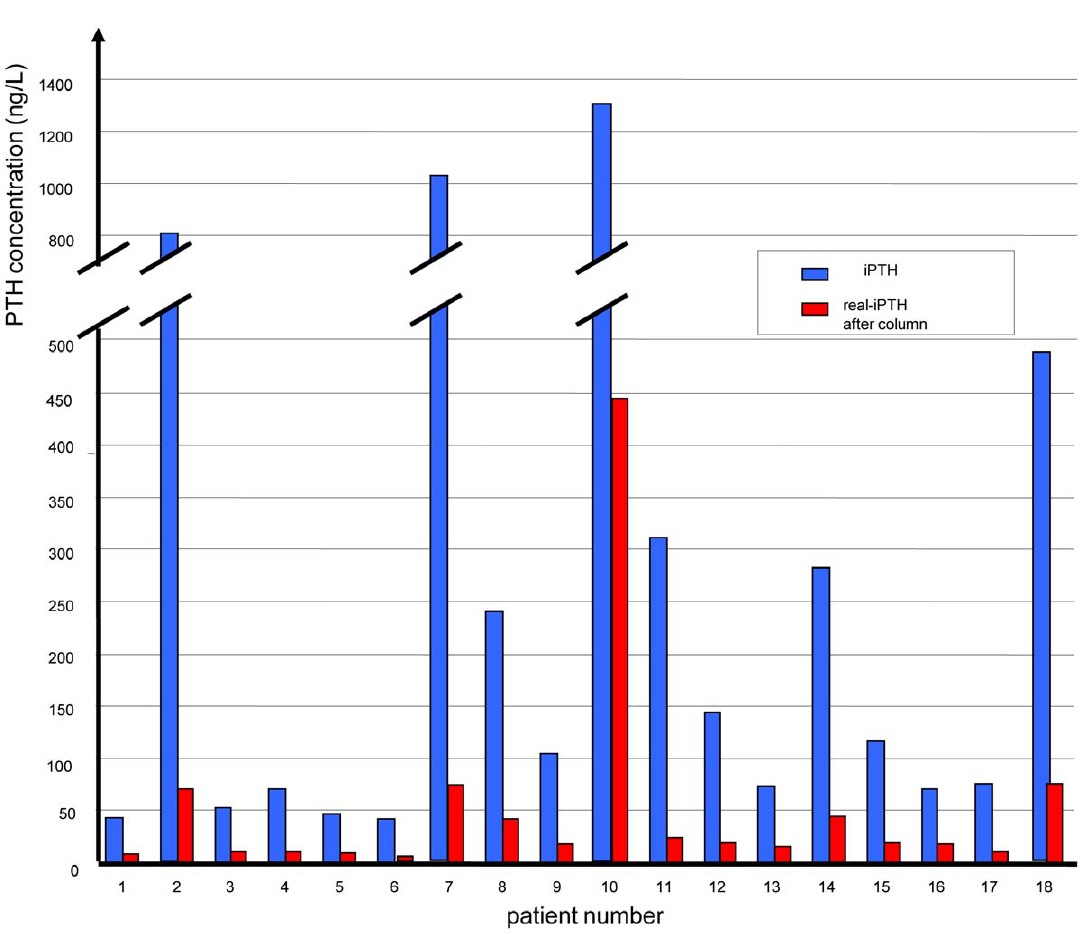
Figure 7. We measured intact PTH using the intact PTH assay as described in the method section in 18 patients on dialysis (blue bars), for further detail see also table 2. When removing the oxidized forms of PTH from the sample as illustrated in figure 6, the results were completely different (red bars). The effect of oxidation of PTH is highly variable among these patients requiring dialysis. There is only a very weak correlation between traditionally measured PTH and PTH data considering the oxidation of this hormone.